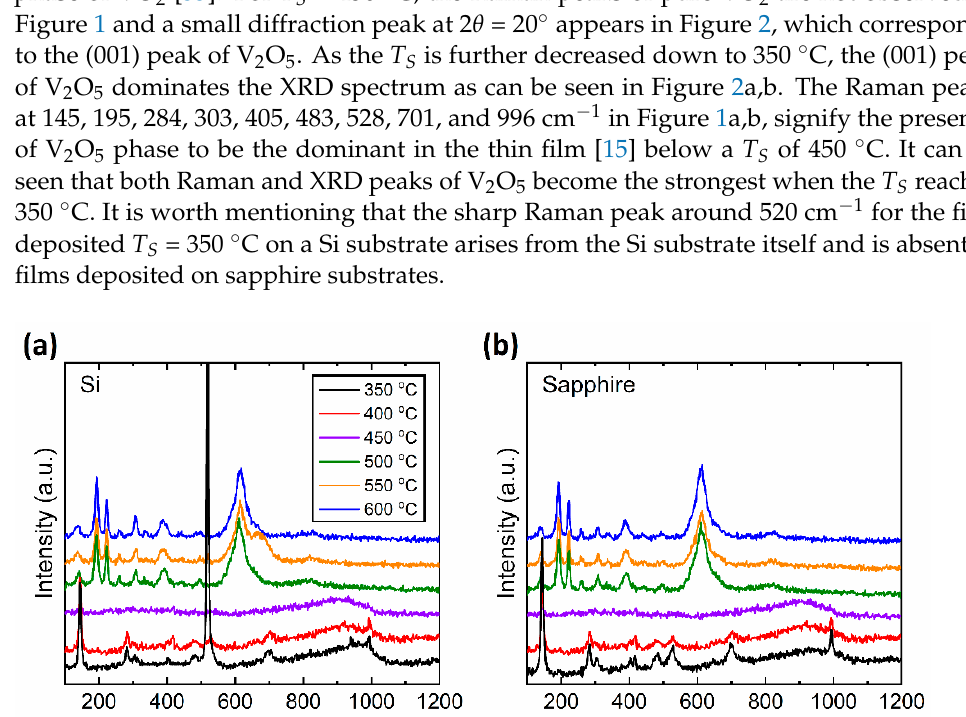
Figure 2. XRD spectra of VO 2 and V 2 O 5 thin films prepared at various substrate temperatures ( T S ) on ( a ) Si and ( b ) sapphire substrates. Note that the vertical axes are in arbitrary units (a.u.). 3.2. Surface Morphology and Roughness Characterization by SEM and Profilometry Figure 3 presents the SEM surface images of the as-prepared VO 2 thin films. It can be observed that the T S affects the surface morphology of the thin films. As observed from (a) to (b) to (c) the films show a misoriented crystalline structure with grain sizes ranging between around 100 and 150 nm. The substrate temperatures of 450 and 400 °C produce V 2 O 5 nanostructured films with smooth surfaces. When the T S is lowered to 350 °C the V 2 O 5 grains become clearly discernable in the films. Surface profilometry shows that T S also affects the surface roughness of VO 2 films. Figure 4 shows the surface profile images of the VO 2 films deposited at various T S -values. These images are taken at a surface area of approximately 0.6 × 0.6 mm 2 of each film. Roughness measurements show that the root- mean-square ( R q ) roughness of films on both Si and sapphire substrates increases as T S is lowered. The maximum R q measured was obtained for VO 2 films deposited at 500 °C, with 10 nm for films on Si and 8 nm for films on sapphire substrates. The minimum R q is meas- ured for films deposited at 600 °C as 4 nm on Si and 3 nm on sapphire substrates. Yet, these films show increased roughness compared to the films prepared at 650 °C [17]. The R q is measured as 3 nm on Si and 2 nm on sapphire substrates for films prepared at 650 °C. These, in fact, manifest properties associated with high-quality VO 2 films as investi- gated previously [36]. Nevertheless, the average roughness ( R a ) does not exhibit a strong